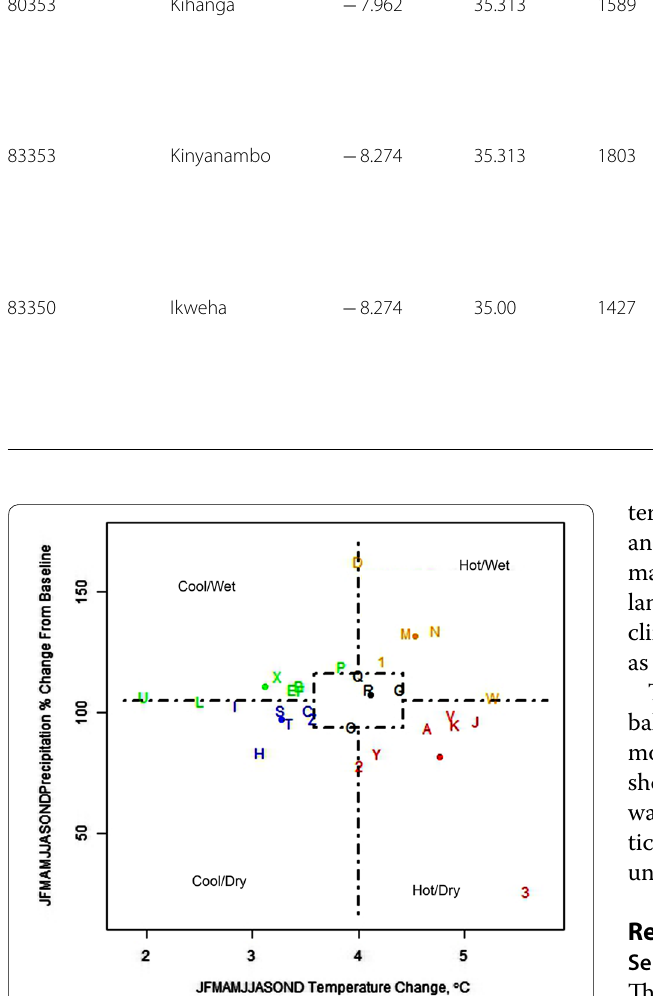
Fig. 9 Temperature-and-Precipitation change scatter diagram for Kinyanambo station